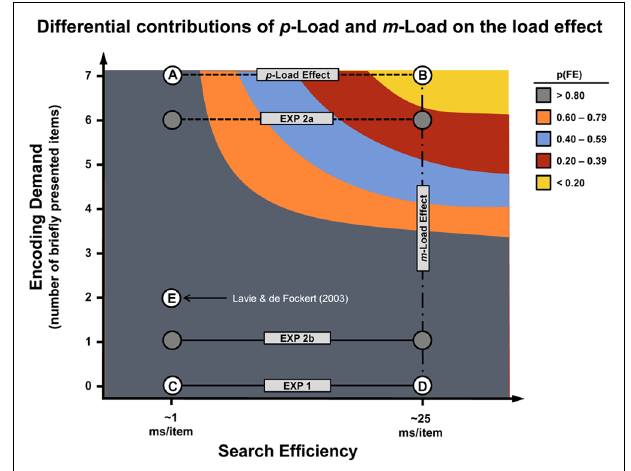
FIGURE 6 | Load effect “resources.” This empirically derived model illustrates two forms of “resource” demand – feature- and encoding-based – that impinge upon selective attention to produce the load effect (denoted by dashed lines).The vertical axis denotes the m -Load and is quantified as the number of briefly exposed display stimuli.The horizontal axis denotes the p- Load and is quantified in terms of the search efficiency of the displays.These values are estimated based on our previous work exploring the role of visual search and load (Duncan and Humphreys, 1989; Roper etal., 2013). Points A and B represent the canonical low p- Load and high p- Load tasks, respectively.Tasks represented by point A and B served as control conditions for Experiments 1 and 2. Low p- Load was characterized by a conspicuous target (search efficiency ∼ 1 ms/item), whereas high p- Load was characterized by an inconspicuous target (search efficiency ∼ 25 ms/item) – both conditions are characterized by high m- Load (7 stimuli at 100 ms exposure). Experiments 2a and 2b, denoted by filled circles, were hybridized and fall between line segments AB and CD in terms of m- Load (see Experiment 2 methods). Point C represents a low m- Load, low p- Load task and point D represents a low m- Load, high p- Load task (both unique to Experiment 1). Point E reflects a high m- Load, low p- Load task (Experiment 2, Lavie and de Fockert, 2003). N.B., although feature competition and encoding demands can be manipulated orthogonally, it is not entirely clear whether these factors are psychologically independent. The shape of the curve is intended for demonstration